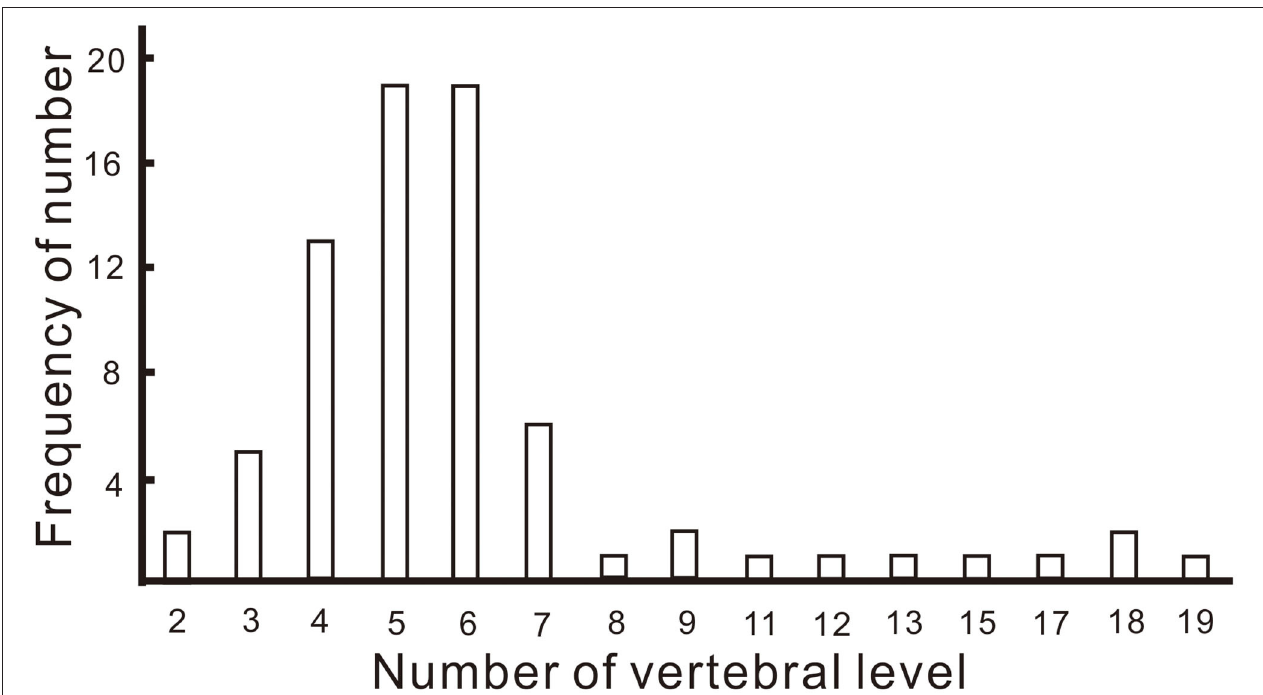
FIGURE 2 | Frequency of the number of vertebral levels over which lesions of the spinal cord extended.